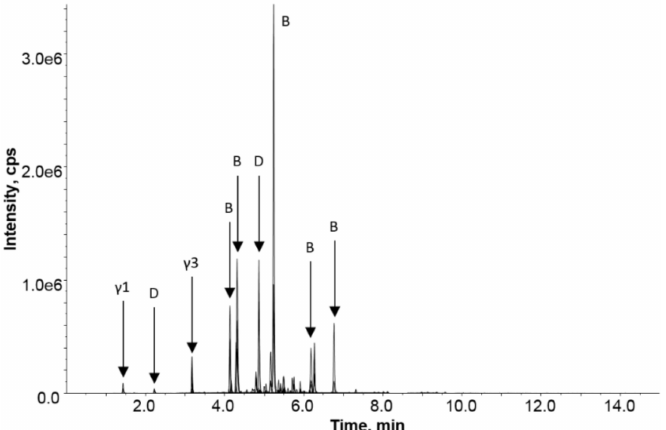
Figure 6. LC-MRM-MS analysis of the savory spread (SS) reveals the detection of barley, as expected, based on barley malt extract—A primary ingredient. The extracted ion chromatogram for barley peptide markers is depicted as intensity (counts / s) versus retention time